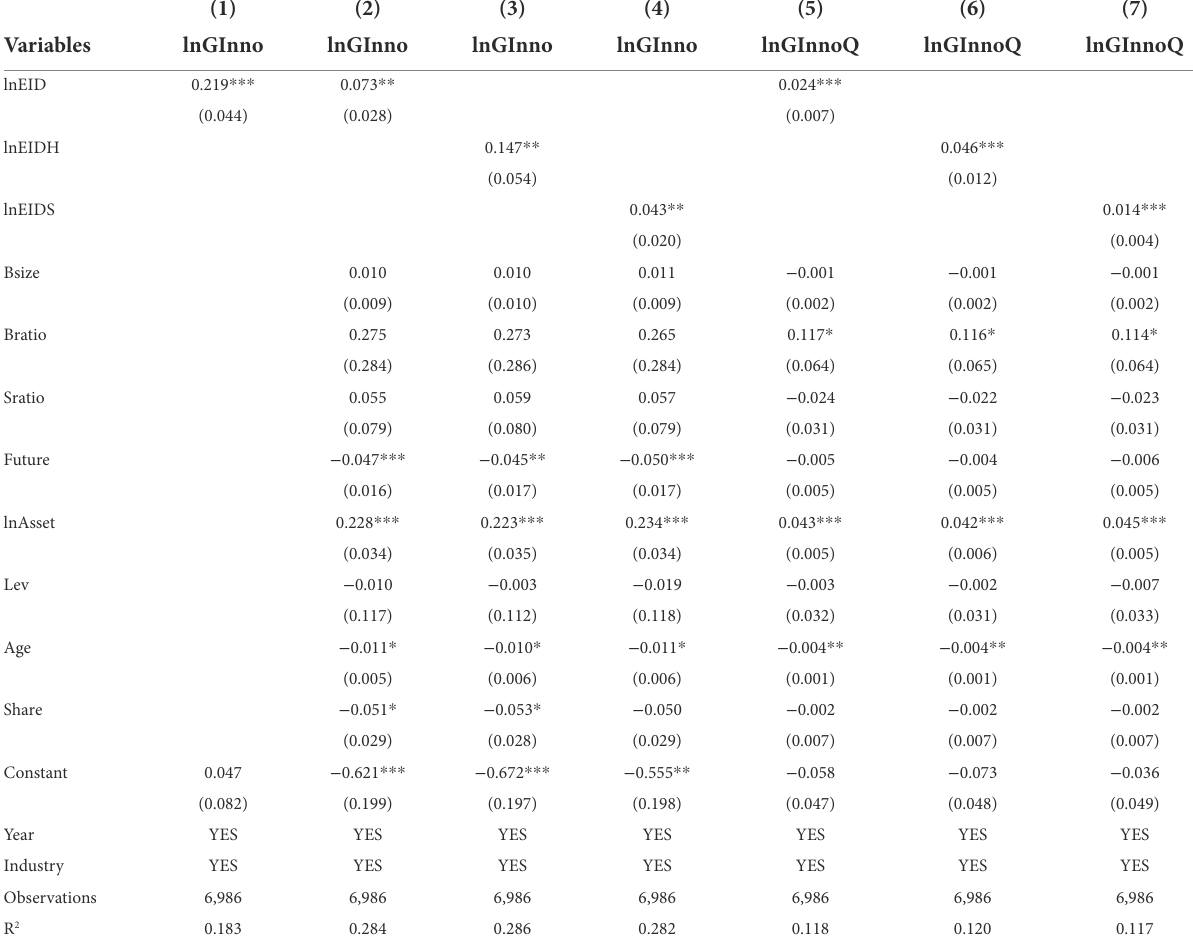
TABLE 3 Benchmark